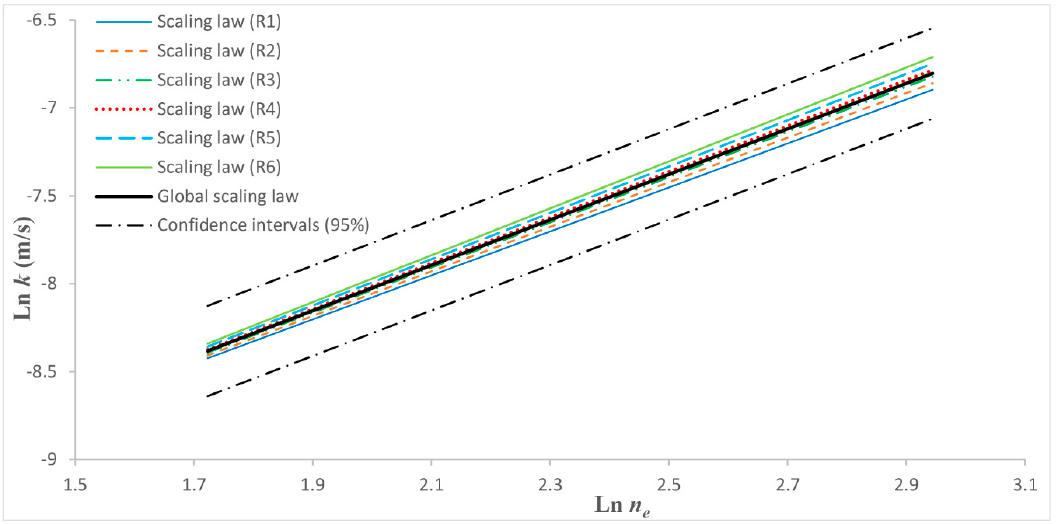
= K ( n e ) and corresponding confidence intervals